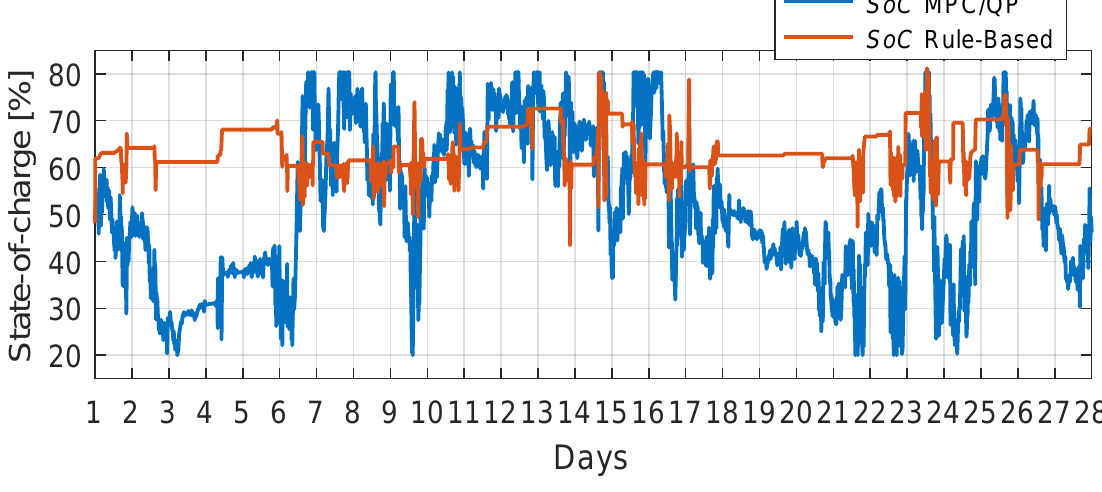
Figure 32. MPC/QP and rule-based algorithms: state-of-charge with λ 1 = λ 2 = 50, commitment with maximum 10% error, initial SoC of 50%, and 50% as SoC set-point.